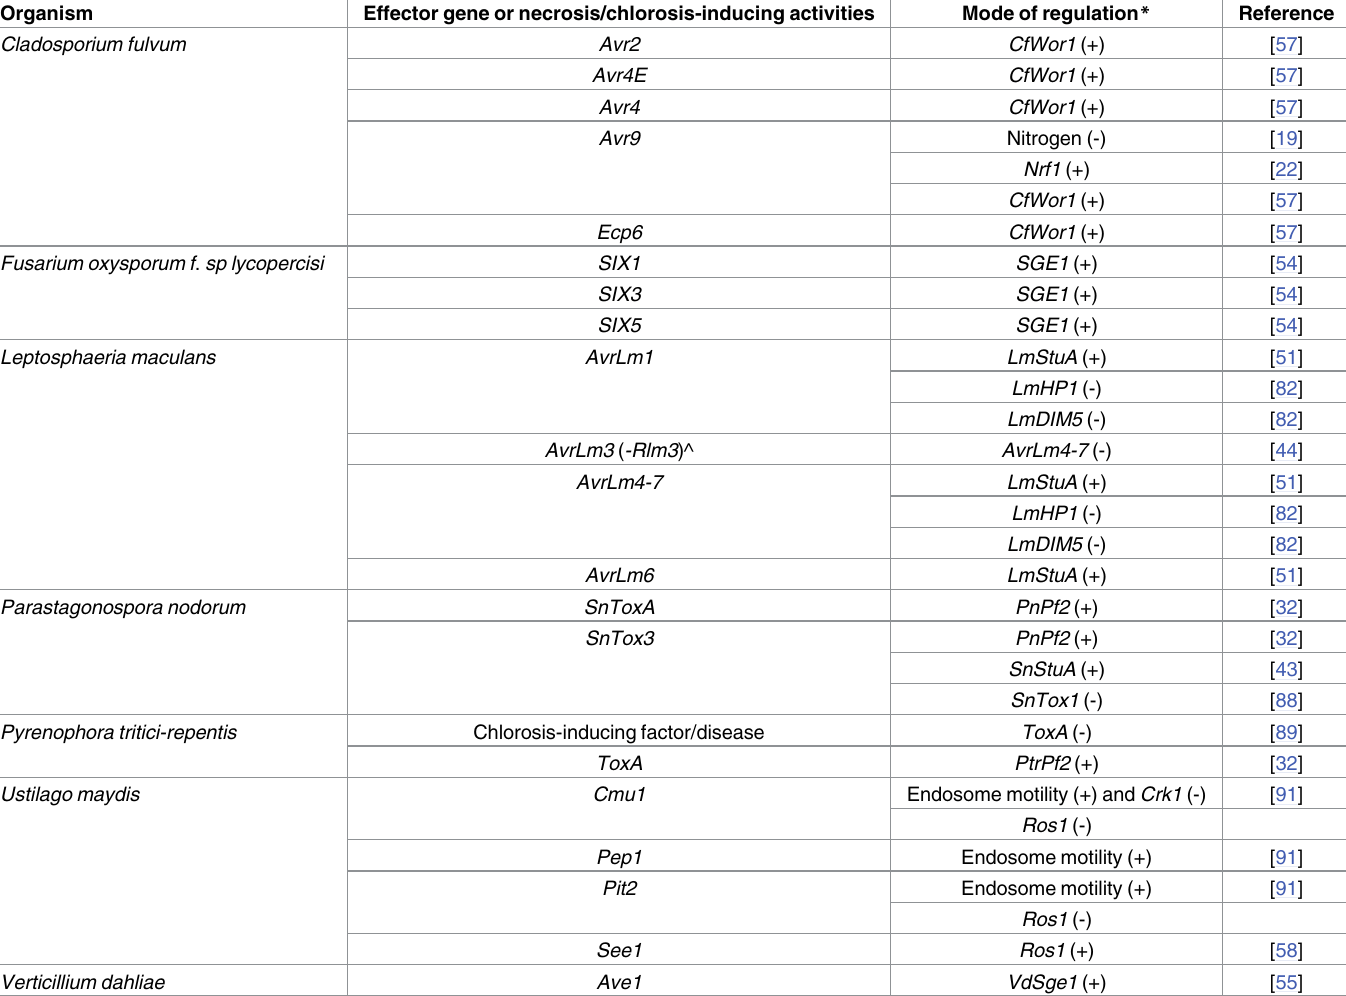
Table 1. A summary of characterised fungal effector genes and their regulatory